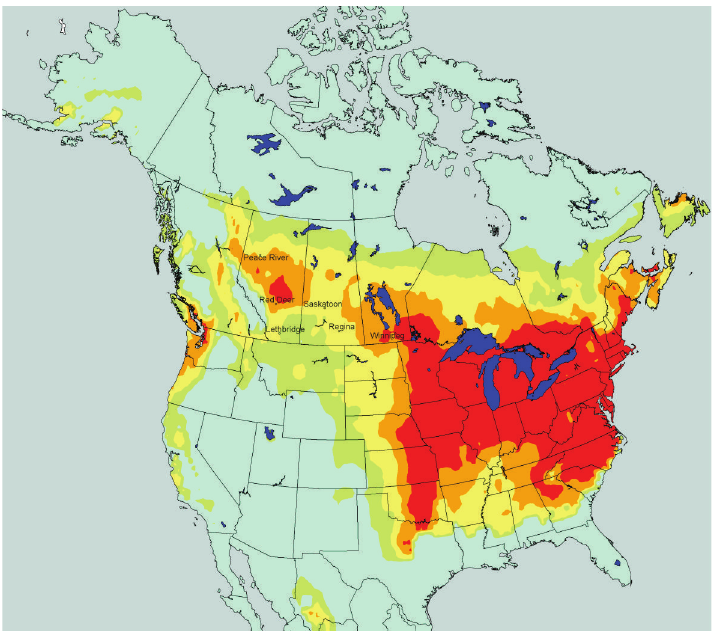
Figure 2: Potential distribution and relative abundance of Sitona lineatus in North America as predicted by CLIMEX under current climate conditions. Dark blue: lakes; Light blue: “Unfavourable” (EI = 0–5); Green: “Marginal” (EI = 5–10); Yellow: “Suitable” (EI = 10–15); Tan: “Favourable” (EI = 15–20); Red: “Very Favourable” (EI >